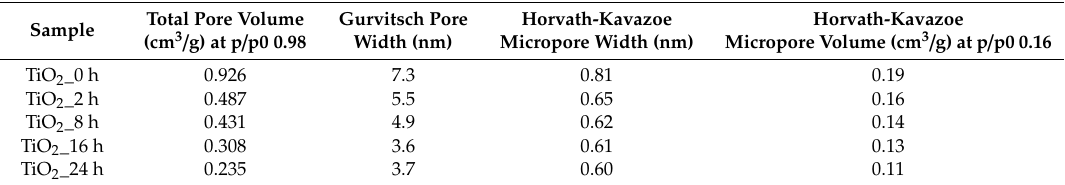
Table 4. Porosity values of TiO 2 samples calculated by the Gurvitsch (4V / A) and by Horvath-Kavazoe